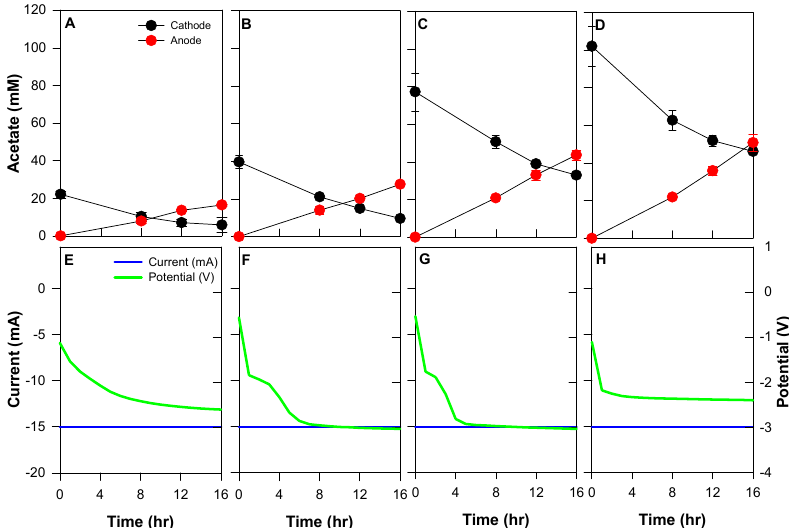
Figure 3. Change in acetate concentration by electrodialysis under various initial acetate concentrations in the cathode chamber, 20 mM ( A , E ), 40 mM ( B , F ), 80 mM ( C , G ), and 100 mM ( D , H ). The applied potential was fixed to − 15 mA.